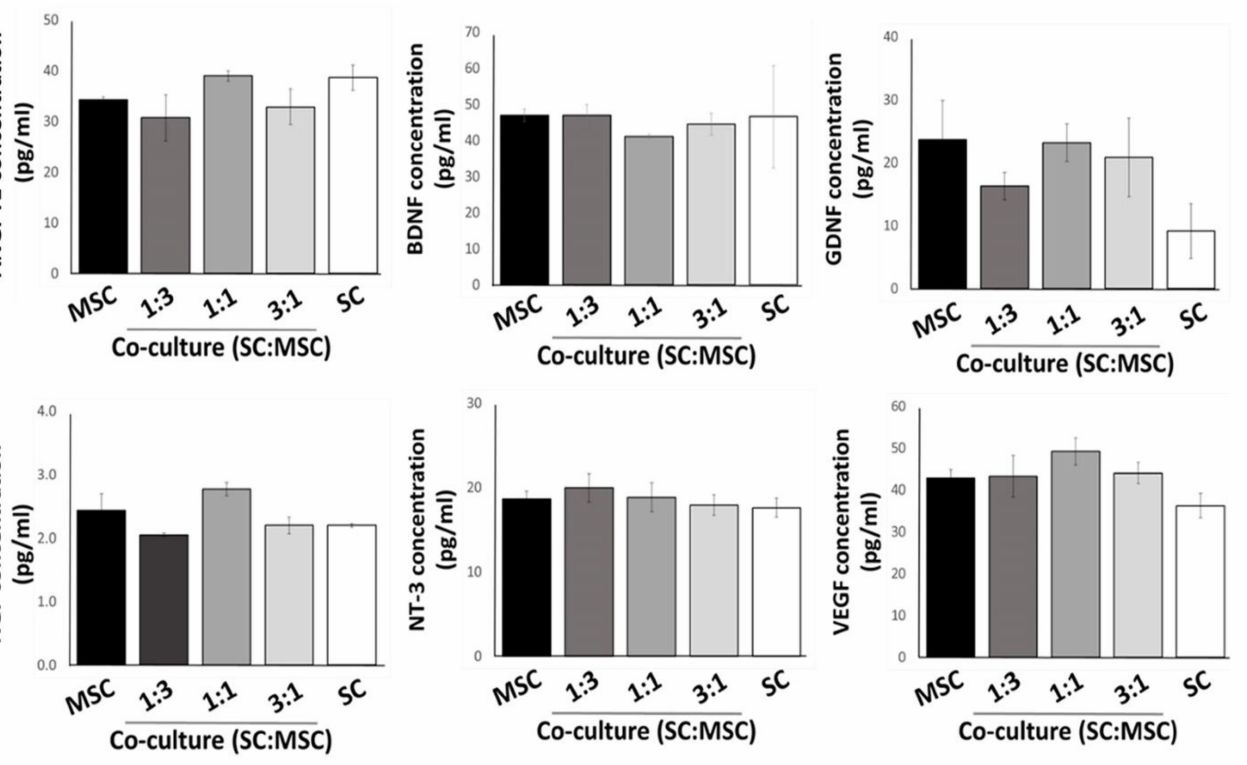
Figure 3. ELISA analysis of culture media samples taken from MSCs, Schwann cells (SC), and varied co-culture compositions of both cell types. Error bars are standard errors from the mean, n =